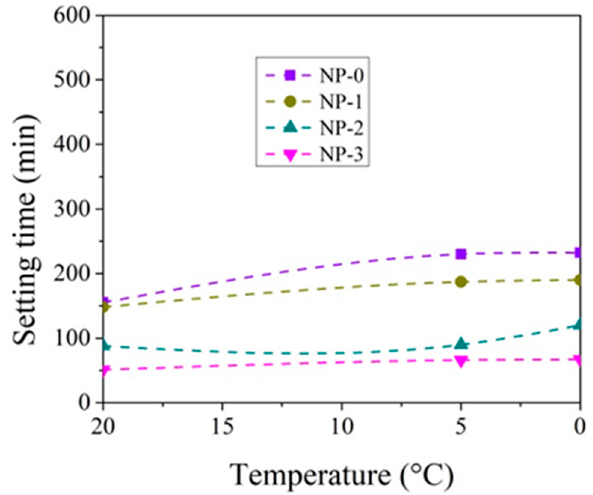
Figure 4. Initial setting times of CEM IIN paste with 0–3% CN at different temperatures.